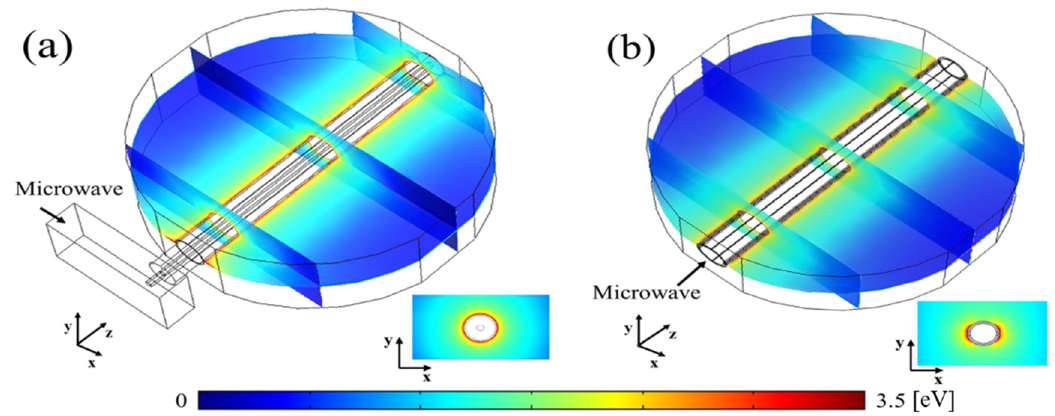
Figure 10. Electron temperature at 500 [mTorr] MWP. ( a ) TEM mode of quasi-coaxial linear MWP ( b ) circular TE 11 mode waveguiding structure MWP.